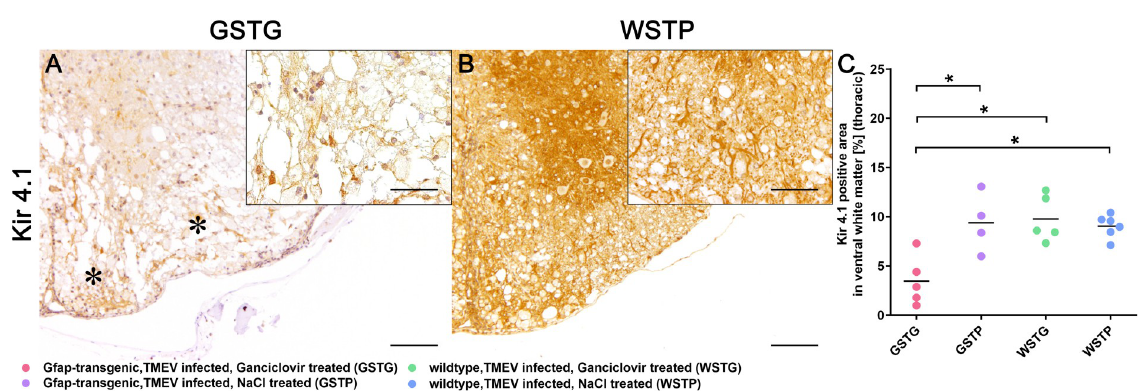
Fig 5. Effects of astrocyte depletion upon Kir 4.1 potassium channels. Immunohistochemistry targeting Kir 4.1 potassium channels revealed a significant reduction of Kir 4.1 positive area (asterisks, A ) in the thoracic spinal cord of TMEV infected, ganciclovir treated, GFAP- transgenic (GSTG) mice compared to control animals ( B, C ). Inserts visualize in more detail the intralesional reduction of Kir 4.1 in astrocyte depleted animals ( A ) compared to the WSTP control group ( B ). For each antibody, one cross section of the thoracic spinal cord was evaluated per animal. Data are shown as scatter dot plots. The horizontal bar indicates the mean. Significant differences between GSTG and the control groups obtained by Kruskal-Wallis test followed by Mann–Whitney U post hoc tests are indicated by � , p � 0.05. Bars represent 100 μ m in overviews and 50 μ m in the